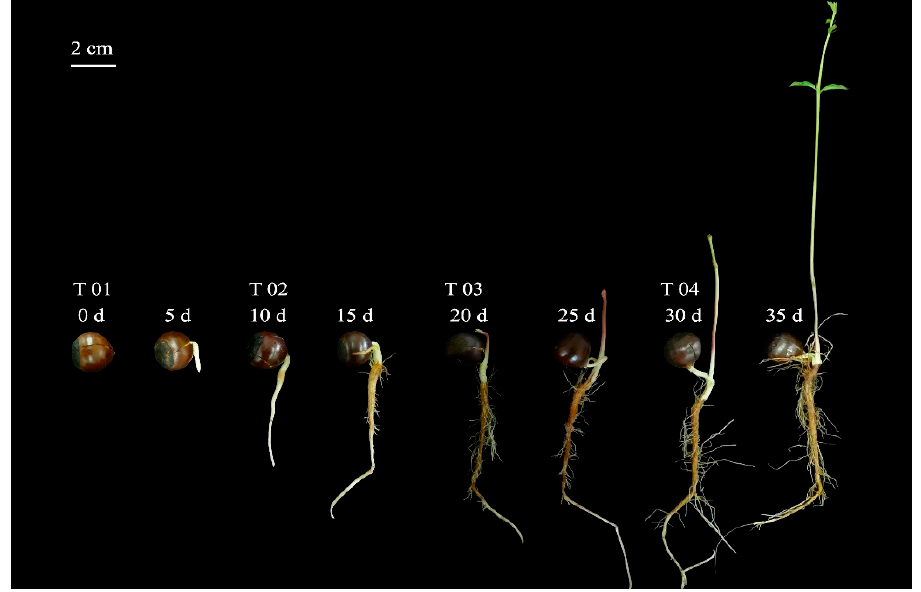
Figure 1. Eight seed germination stages of Castanea henryi . Four developmental stages were sampled for RNA-seq: T01, 0 days; T02, 10 days; T03, 20 days; T04, 30 days.